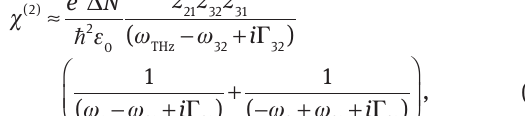
Using the band-structure parameters obtained from the same THz frequency of 3.1 THz. The higher χ (2) value for the previous analysis, we estimate the nonlinearity χ (2) of the DAU active region, compared to that for the BTC active region, is attributed to constructive addition of nonlinear- each active region design by combining the contributions to χ (2) of each of the triplets of states involved in the reso- nant DFG shown in the insets in Figure 3A,B. The contri- bution of each of the triplets can be written as follows: